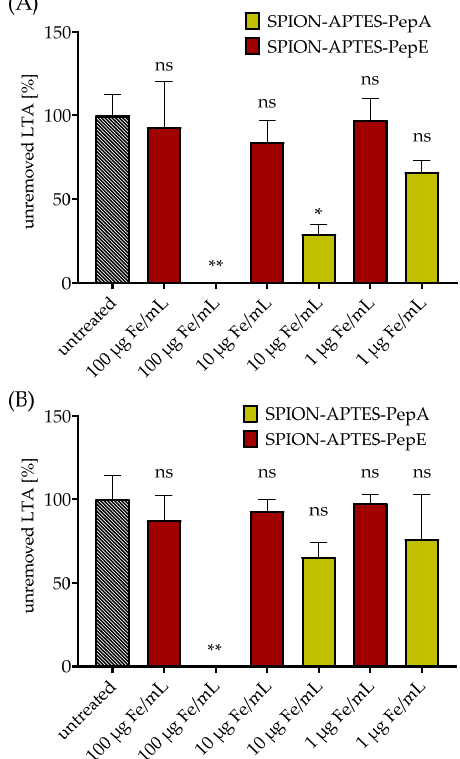
Figure 7. Removal of S. aureus LTA from water-based media. Separations were carried out with LTA concentrations of 10 ng LTA/mL (panel ( A )) and 1000 ng LTA/mL (panel ( B )). SPION-APTES-PepA and SPION-APTES-PepE were used at concentrations of 1, 10, or 100 µg Fe/mL. The results shown represent the mean values with standard deviations of three independent experiments. Statistical testing was performed between untreated and treated samples using a Kruskal–Wallis test with a post hoc Dunn’s test; * p ≤ 0.05; ** p ≤ 0.01. p values above 0.05 were considered non-significant (ns).